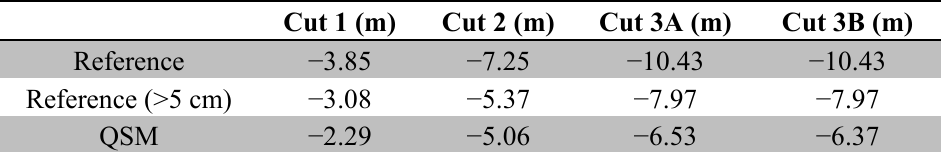
Table 4. Cumulative change of aspen branch length (in metres) after each cut. Cuts 3A and 3B represent two independent scans of the tree after the third cut (the reference being the same). In “Reference (>5 cm)”, the smallest sub-branches (less than 5 cm length) were not included in the total branch